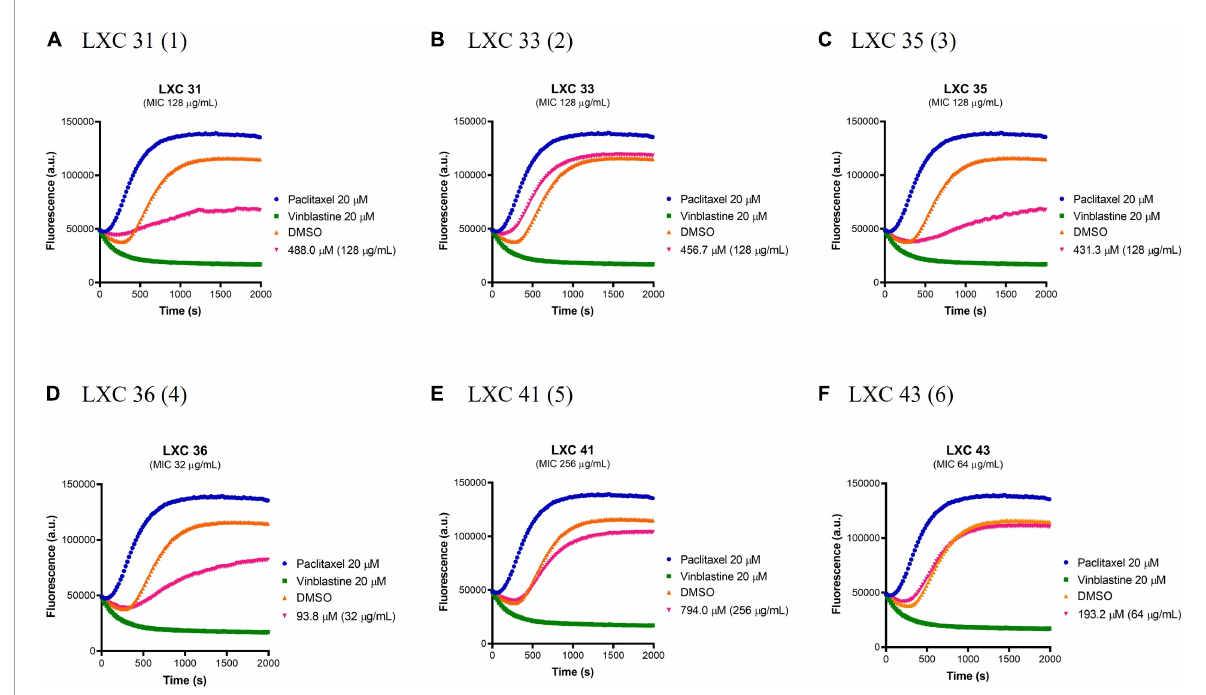
FIGURE7 The effect of the LXC compounds on the polymerization of mammalian tubulin. (A–F) The polymerizing activity of the LXC compounds on porcine tubulin was assessed using a commercial Tubulin Polymerization Assay Kit. The LXC compounds at 1 × MIC were pre-incubated with tubulin on ice before the reaction was initiated by the addition of 1 mM GTP. The fluorescence was measured as a function of time at A 360 and A 420 nm excitation and emission wavelengths, respectively, at the constant temperature of 37 ◦ C. DMSO 2.5% (v/v) (brown curves) was used as vehicle control while paclitaxel (polymerization stabilizer; blue curves) and vinblastine (polymerization inhibitor; green curves) at 20 µ M each were also included as